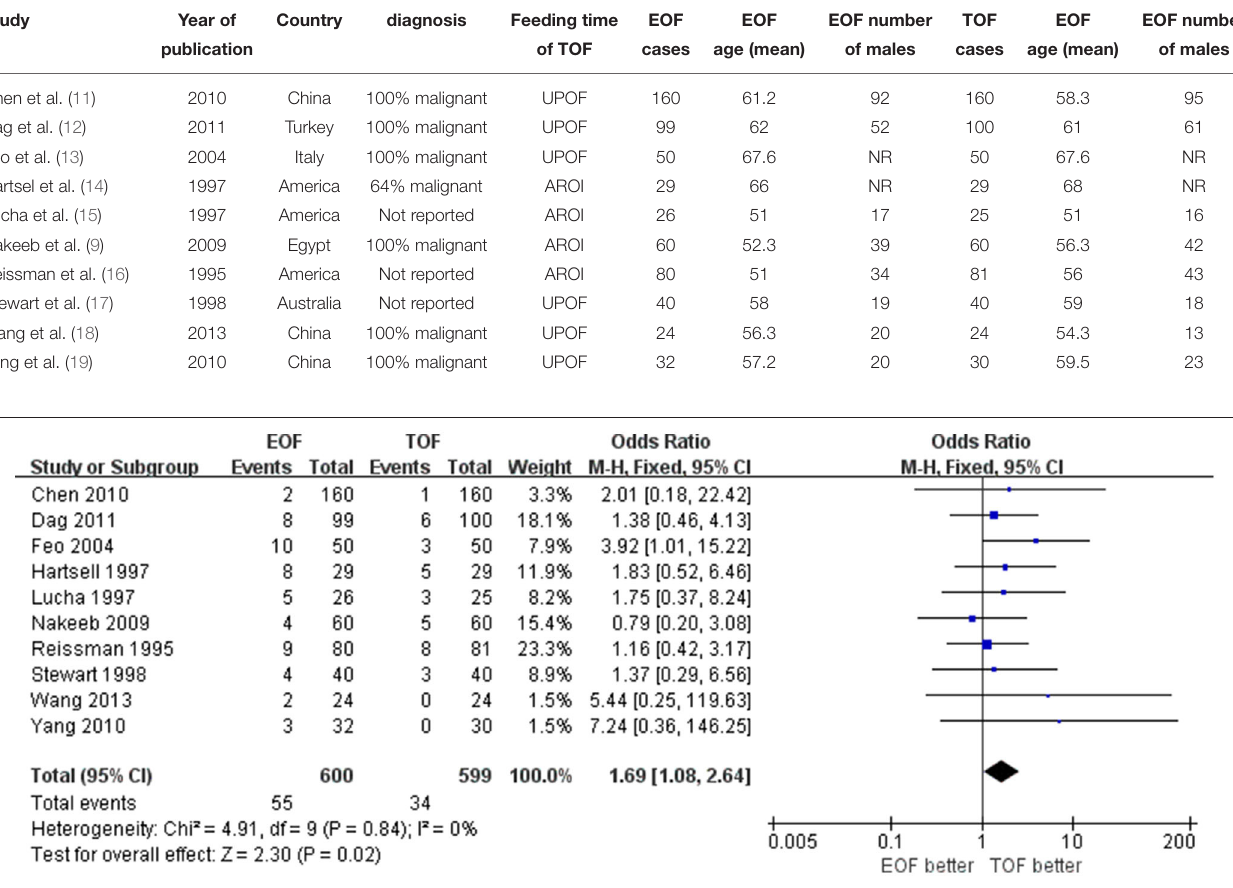
TABLE 1 | Characteristics of the included